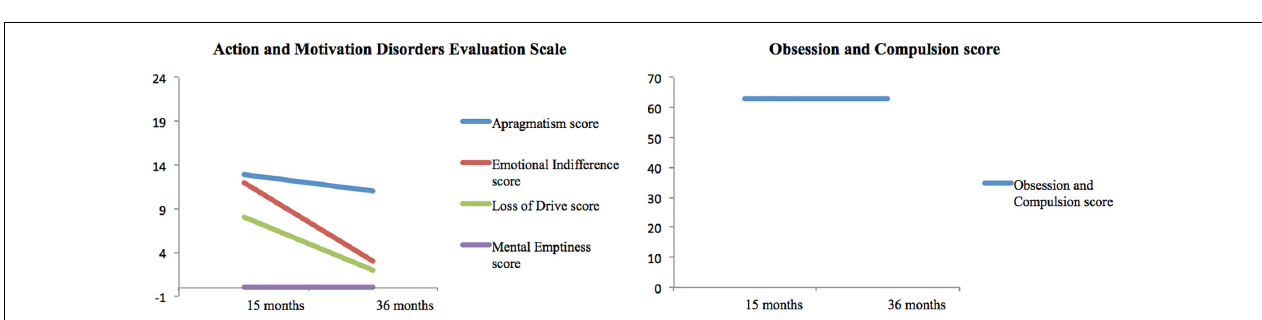
FIGURE 3 | Results of neuropsychiatric evaluation conducted at 15 and 36 months after the onset. In the Action and Motivation Disorders Evaluation Scale (Habib, 1995), the maximum score for each measure is 24. In this scale, higher scores reflect higher impairment. In the Obsession and Compulsion Evaluation Scale (Frankel et al., 1986), subjects without obsessive or compulsion symptoms score below